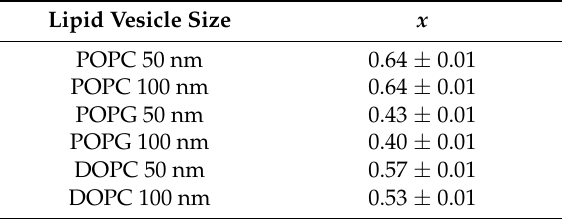
Table 3. The orientation distribution of bR in three types of lipid vesicles with different curvatures. (the value of x indicates the percentage of the TAMRA-bR with N-terminus pointing inside the